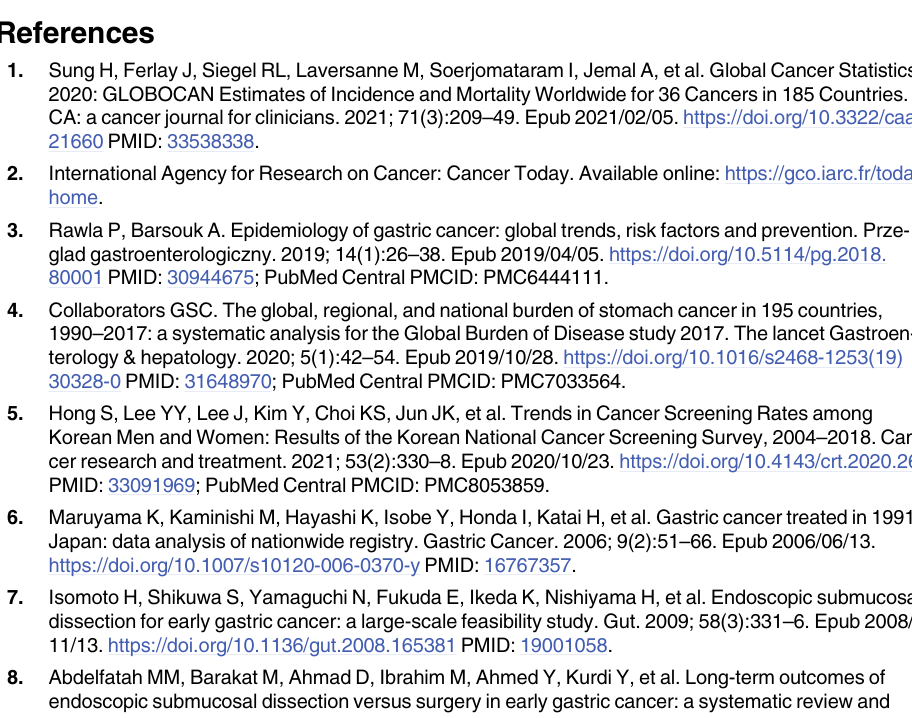
Fig 5. Pooled ORs of (A) tumor size, (B) depth of invasion, (C) pure undifferentiated type, (D) mixed type, (E) lymphovascular invasion, and (F) ulceration as risk factors for LNM.